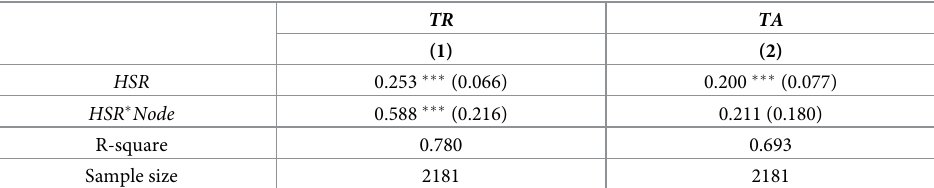
R-square Sample size 2181 2181 Note ��� , �� , and � represent significance levels of 1%, 5%, and 10%, respectively; the values in parentheses are robust standard errors clustered at the city level; TR = Tourism revenue; TA = Tourist arrivals; other controls include ES = Economic scale; FE = Fiscal expenditure; TCD = Transportation convenience degree; IS = Industrial structure; SIS = Service industry support; PS = Population size; IL = Income level; OD = Opening degree; both city and year fixed effects are controlled in all the